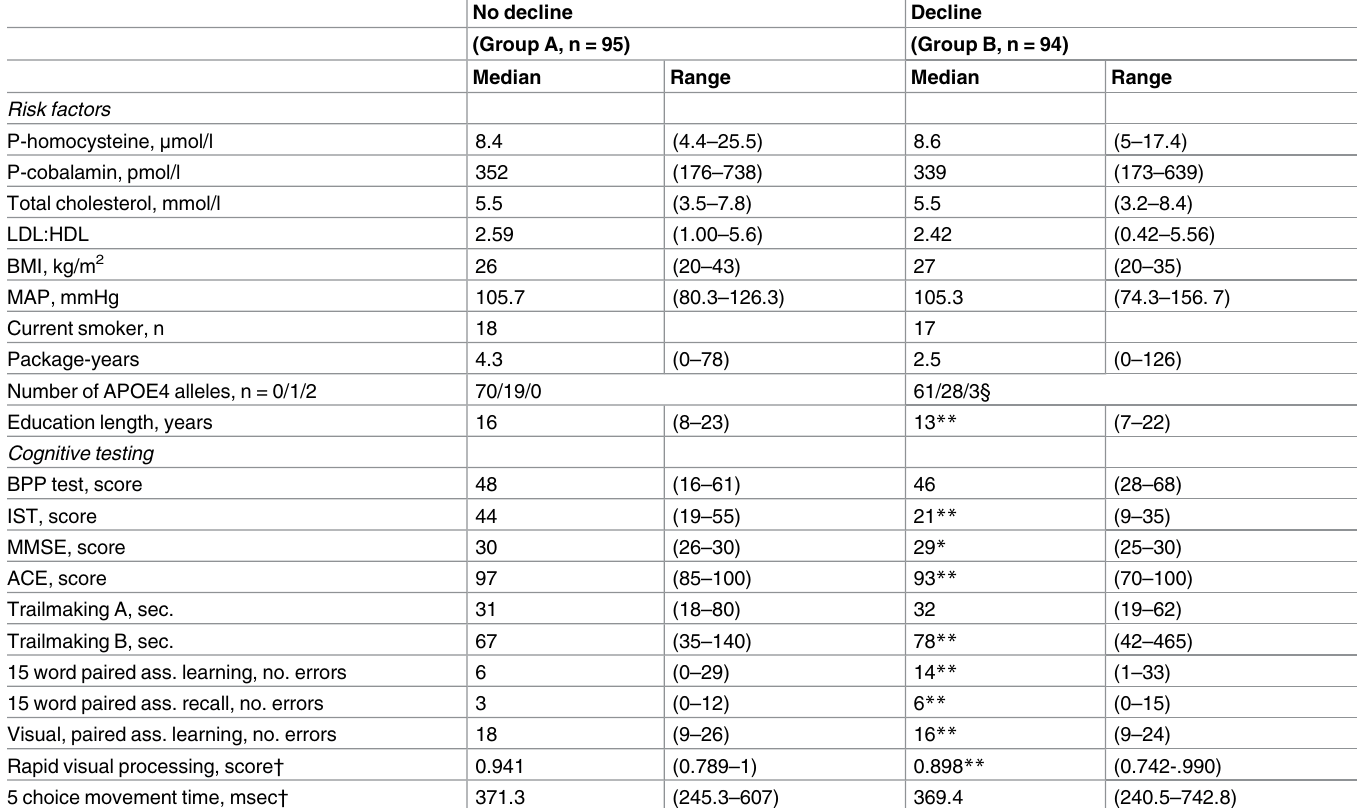
Table 1. Study population